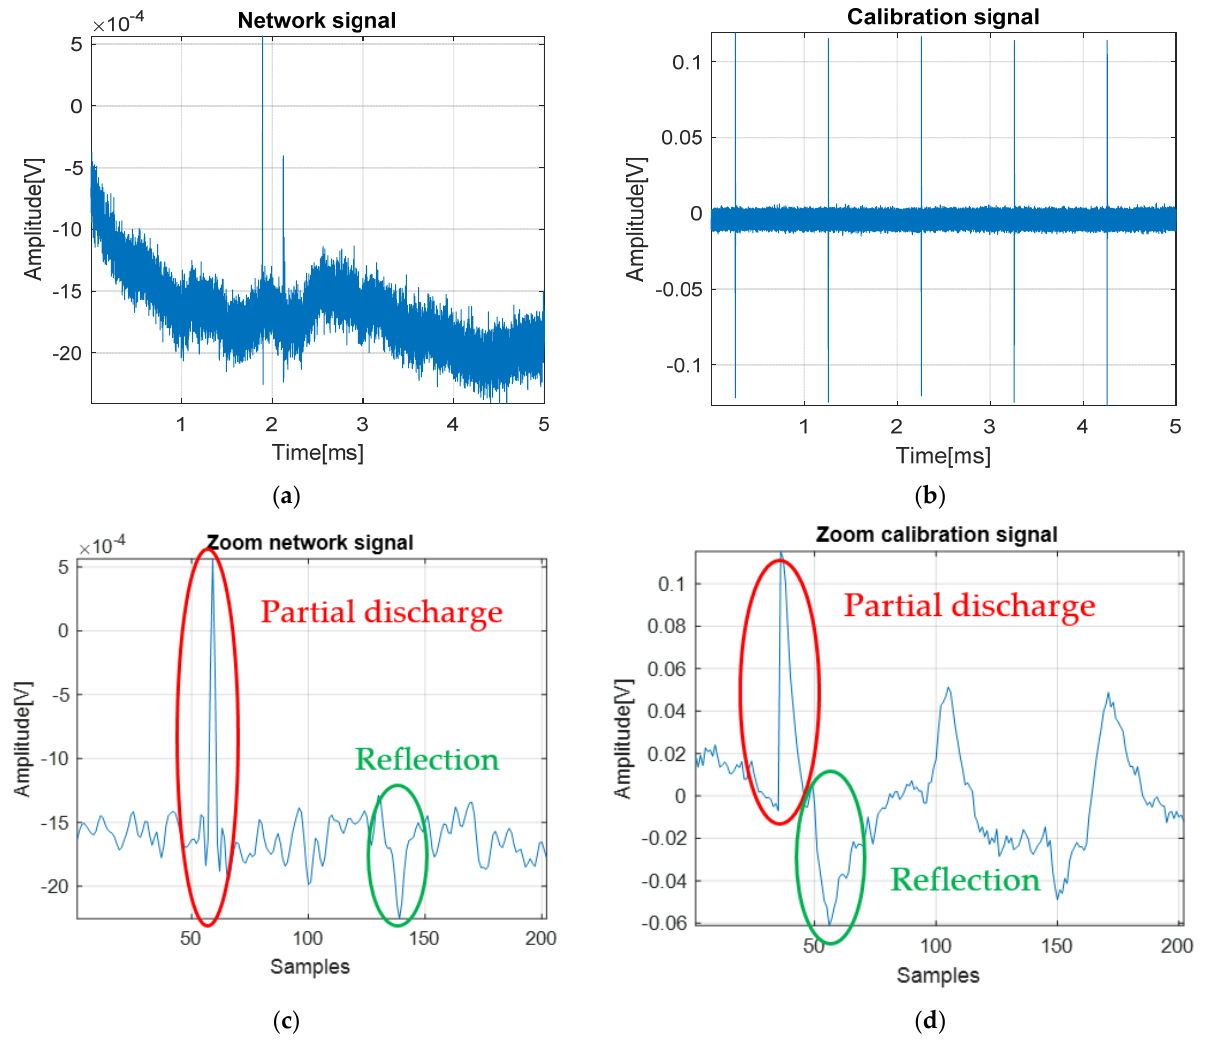
Figure 10. ( a ) Network signal; ( b ) calibration signal; ( c ) zoom of the network signal; ( d ) zoom of the calibration signal.